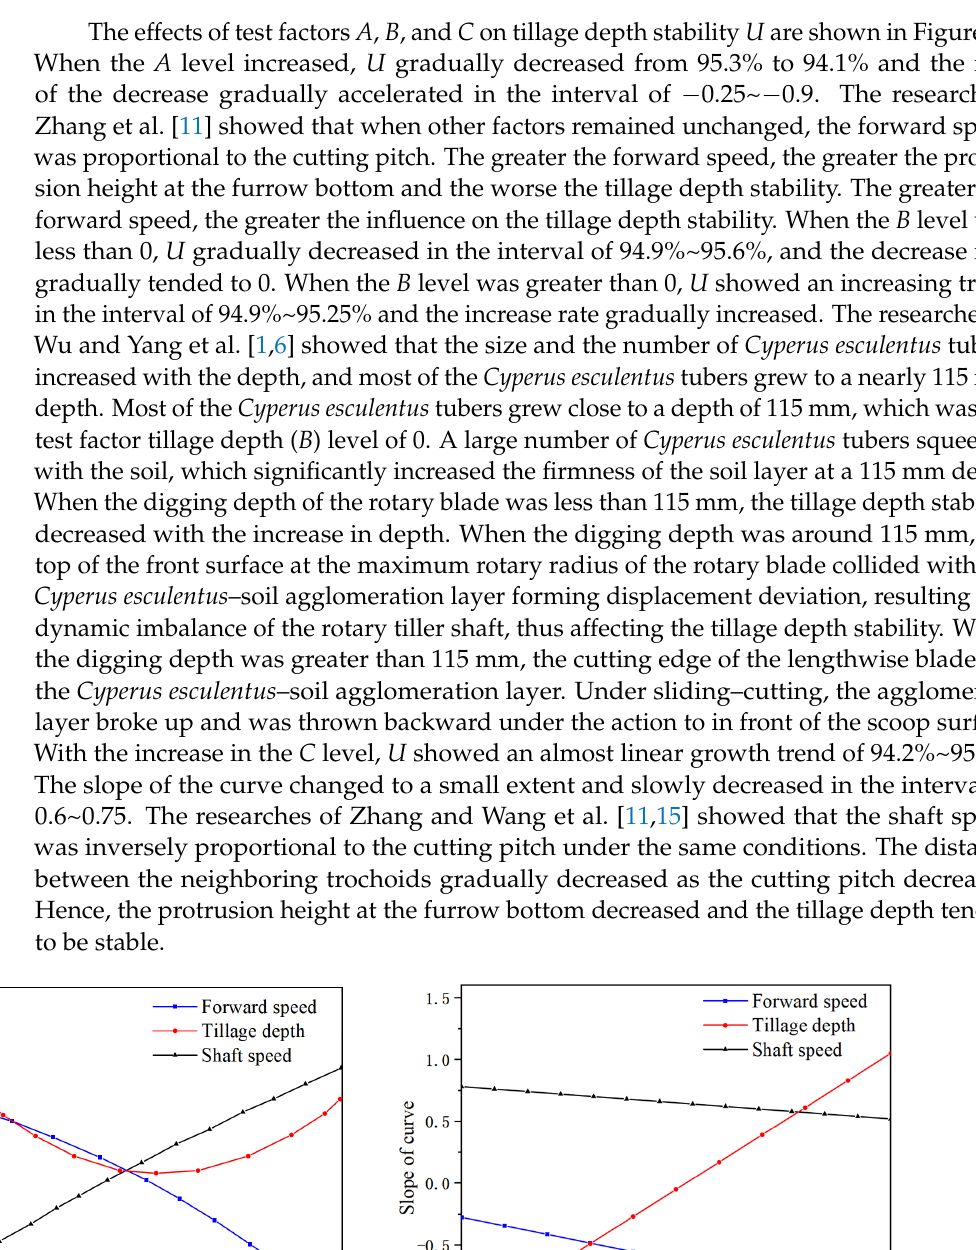
Figure 18. Response surface variation relationship influencing factors on the tillage depth stability. 3.2.2. Power Consumption of Cyperus esculentus Harvesting Removing non-significant influences, the quadratic polynomial regression equation targeting the power consumption of the rotary tiller was